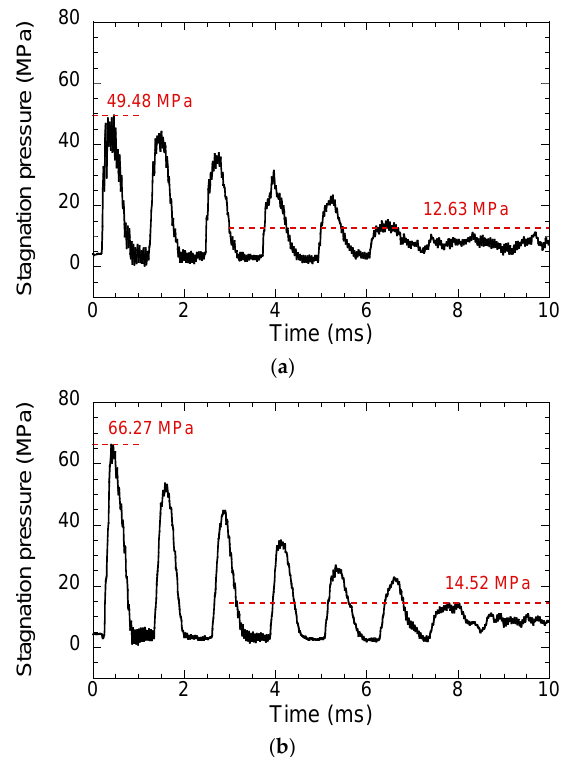
Figure 8. A liquid jet injection by the present detonation-driven injector device into a bloom 250 10% wt. gel as a function of mixture initial pressure.